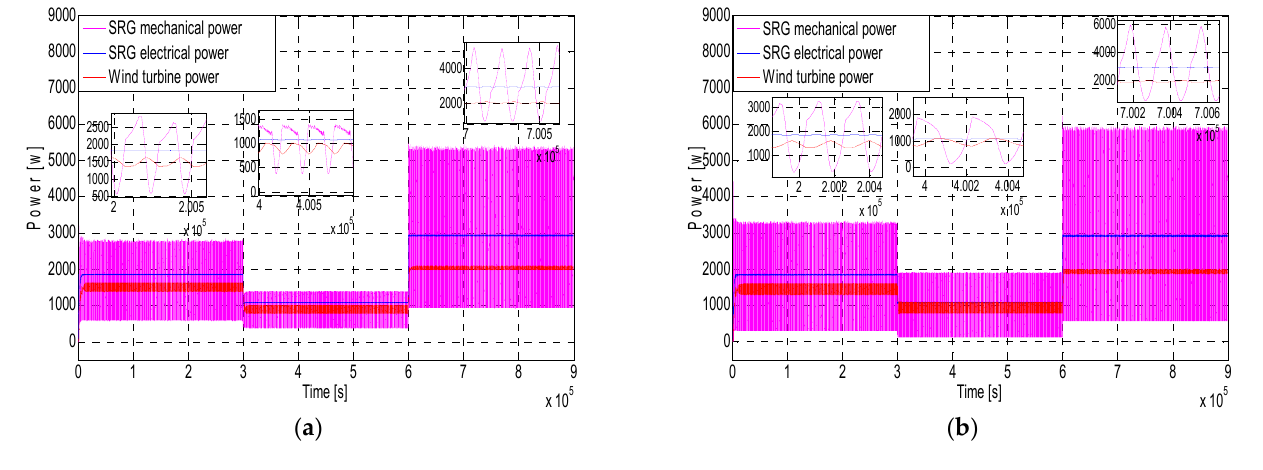
Figure 20. 12/8 SRG and turbine powers using HCC control and MPPT: ( a ) For θ (cid:2925)(cid:2924) (cid:3404) 19° and θ (cid:2925)(cid:2916)(cid:2916) (cid:3404) 38° ; ( b ) For: θ (cid:2925)(cid:2924) (cid:3404) 22° and θ (cid:2925)(cid:2916)(cid:2916) (cid:3404) 35° .